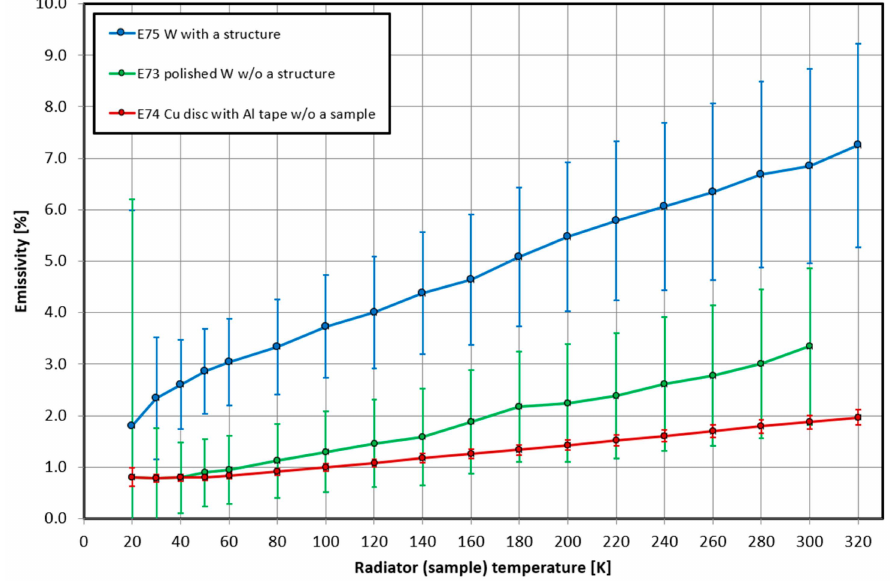
Figure 11. Resulting emissivity of tungsten sample with structure ( blue curve ) after correlation relative to the emissivity of the pure tungsten substrate ( green curve ) and the underlying copper carrier with aluminum tape ( red curve ). Adapted from [15] with kind permission of Brno University of